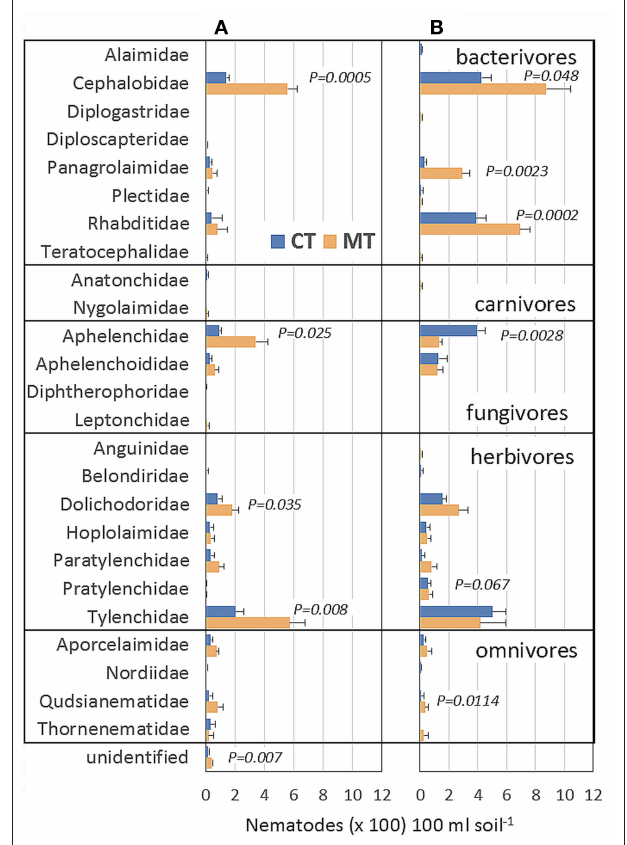
FIGURE 3 | Morphologically identified frequency of nematodes per family in 100ml soil for the first experiment during grass-clover cropping (A) and second experiment after potato harvest (B) under conventional ploughing (CT) and minimum tillage including application of organic mulches (MT). Nematodes are sorted alphabetically within each feeding type. Standard errors and exact p- values ( p < 0.05, df = 6) are shown and result from linear-mixed effects models and contrasts of estimated marginal means. Tillage systems do not differ significantly for any nematode family that lacks a p- value ( p > 0.05).